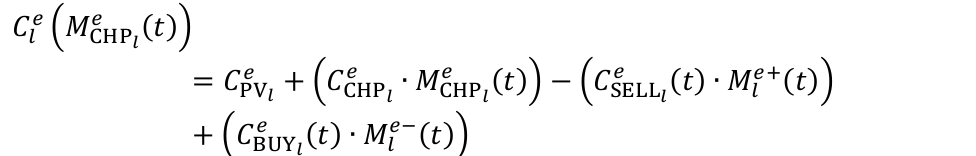
Figure 3. Cases of (cid:1829) (cid:2903)(cid:2889)(cid:2896)(cid:2896)(cid:3032) (cid:4666)(cid:1872)(cid:4667) (cid:3407) (cid:1829) (cid:2886)(cid:2905)(cid:2909)(cid:3032) (cid:4666)(cid:1872)(cid:4667) (cid:3407) (cid:1829) with the electric energy surplus; and ( c ) microgrid with the electric energy